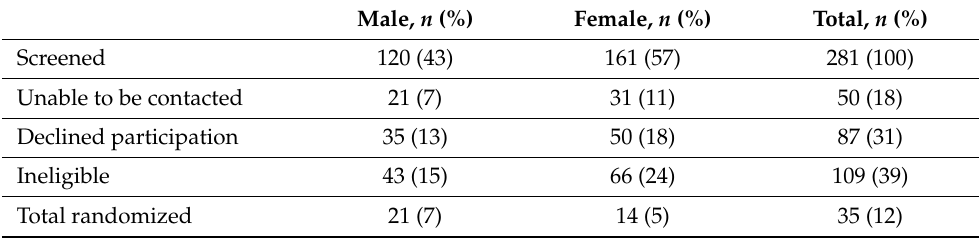
Table 5. Number and proportion (%) of participants randomized compared to total